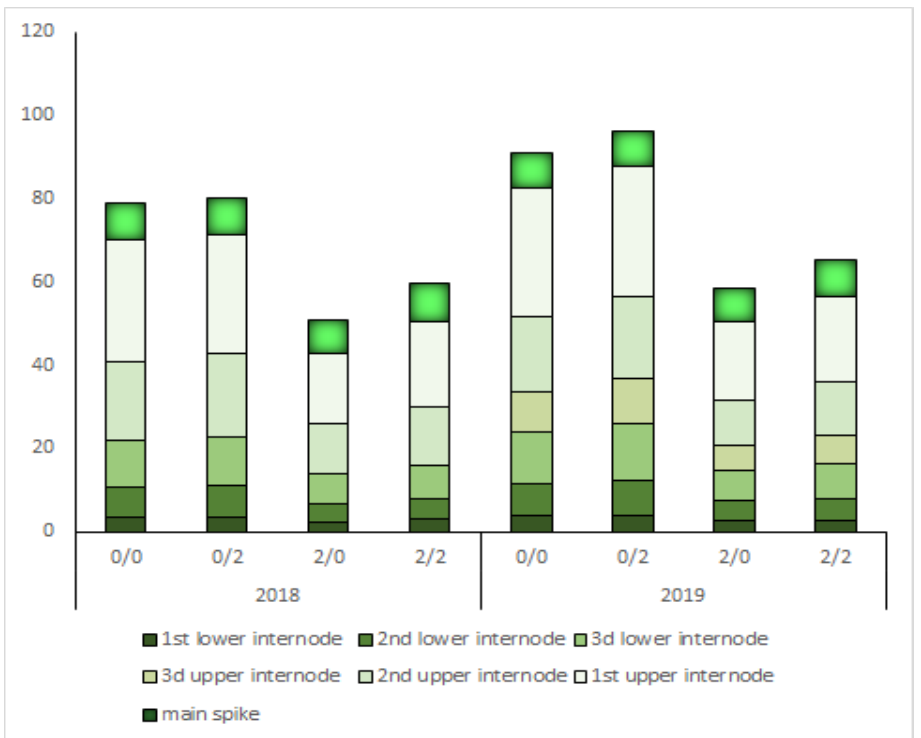
Figure 4. Schematic diagram showing the internode and spike length of the main shoot of spring triticale plants with different combinations of the DDW1 and Grf3 alleles. Genotypes are as follows: 2/2 Ddw1Ddw1Grf3 (274) Grf3 (274), 2/0 Ddw1Ddw1Grf3 (262) Grf3 (262), 0/2 ddw1ddw1Grf3 (274) Grf3 (274), 0/0 ddw1ddw1Grf3 (262) Grf3 (262).